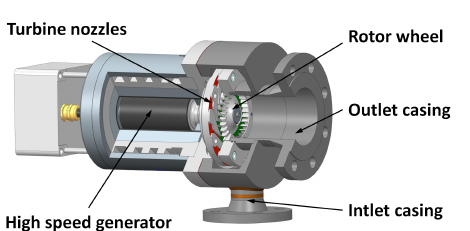
Figure 1. Architecture of the radial inflow cantilever